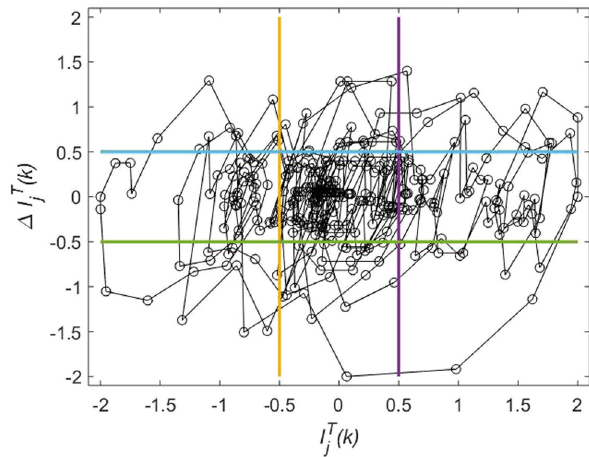
Figure 14: Temporal episodes for the new con fi rmed deaths in